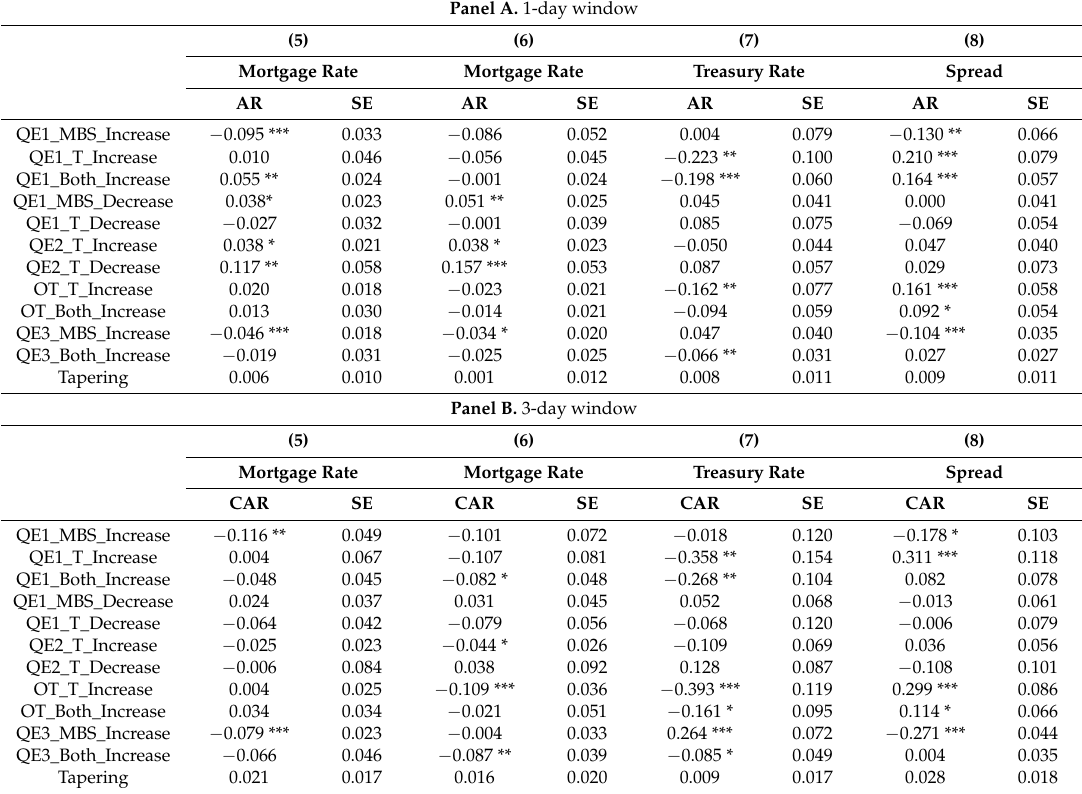
Table 6. Abnormal returns (ARs) and cumulative abnormal returns (CARs) for event groups. A total of 31 QE events are grouped by type of asset purchased, increase or decrease of purchase, and QE round. ARs are reported for the 1-day window and CARs are reported for 3-day and 5-day windows. The ARs used to calculate CARs are not reported for 3-day and 5-day window cases, but can be found in Supplementary Materials, Table